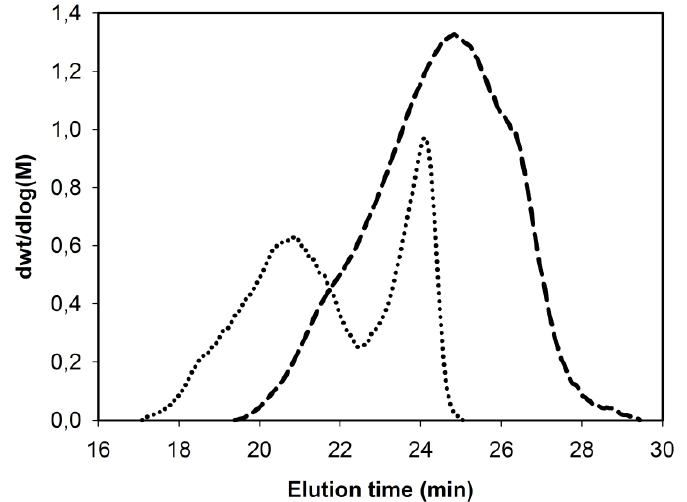
Figure 6. SEC chromatograms obtained for EVOH- g -PCL prepared in mini twin-screw extruder with different ratio of ε -caprolactone. Runs 6 (medium dash) and 7 (dotted) (30 min reaction).